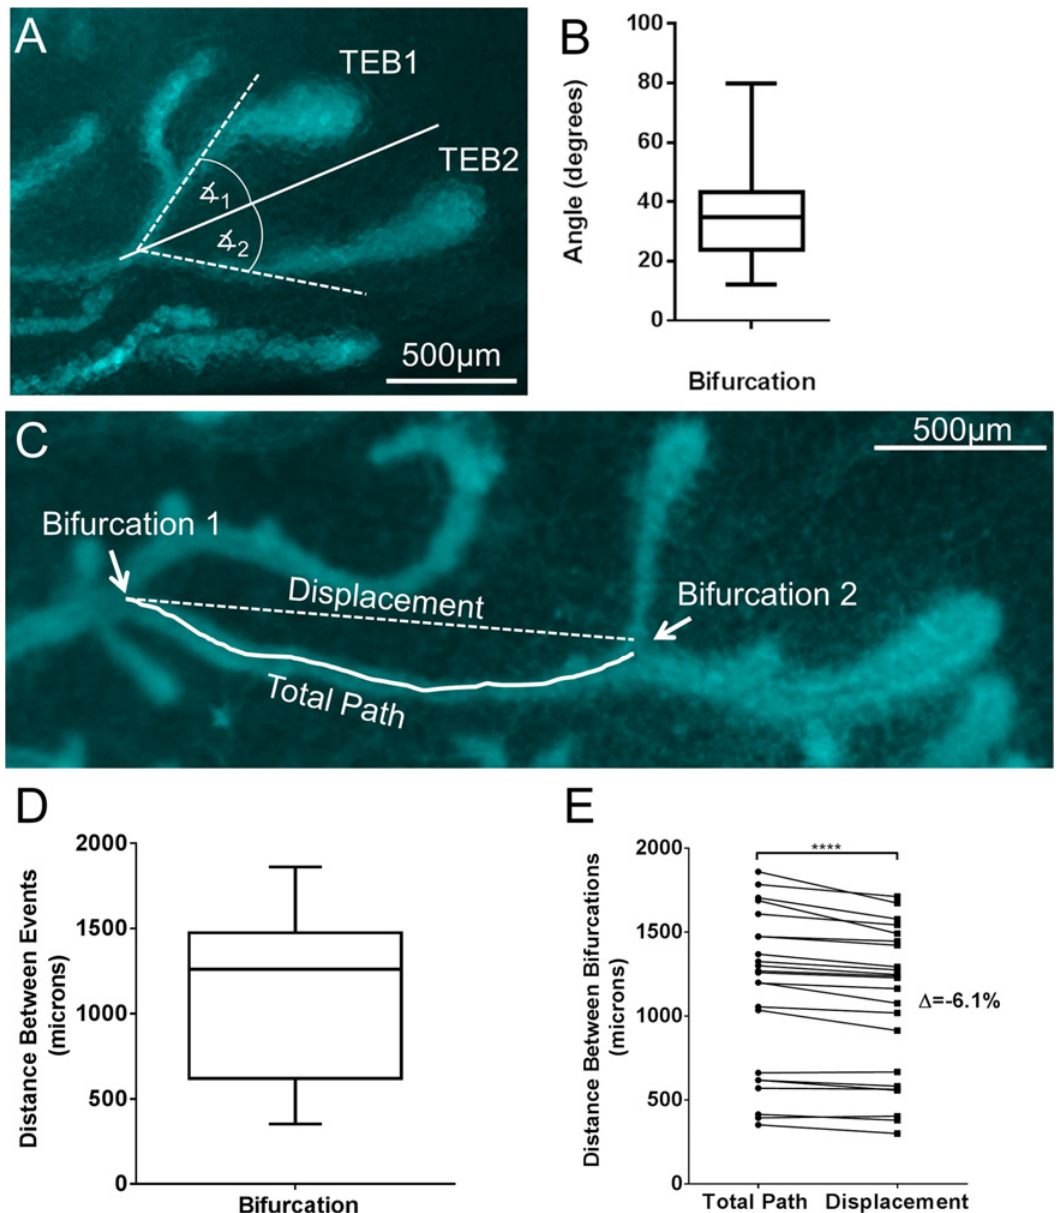
Fig 6. Assessment of TEB path tortuosity. The angle of deflection caused by bifurcation, the frequency of bifurcation, and the disparity between displacement and path tracing measurements were measured. A) Representative image of a TEB bifurcation event with the original path of the TEB noted as a solid line, the new path of each TEB as a result of the bifurcation are noted as dotted lines and the angles measured noted. B) Quantification of the angle of deflection presented as mean (whiskers denote range)(n = 62). C) Representative image of TEB ’ s growth path with 2 bifurcation events noted and the length of duct between noted with a solid line. D) Quantification of the total length of duct between bifurcation events is presented as mean (whiskers denote range) (n = 23). E) Total length of duct measurements were compared to corresponding displacement measurements. Displacement measurements consistently underestimated the total length by 6.1% ( ± 0.9) (p = .0001, paired ratios t-Test, n =